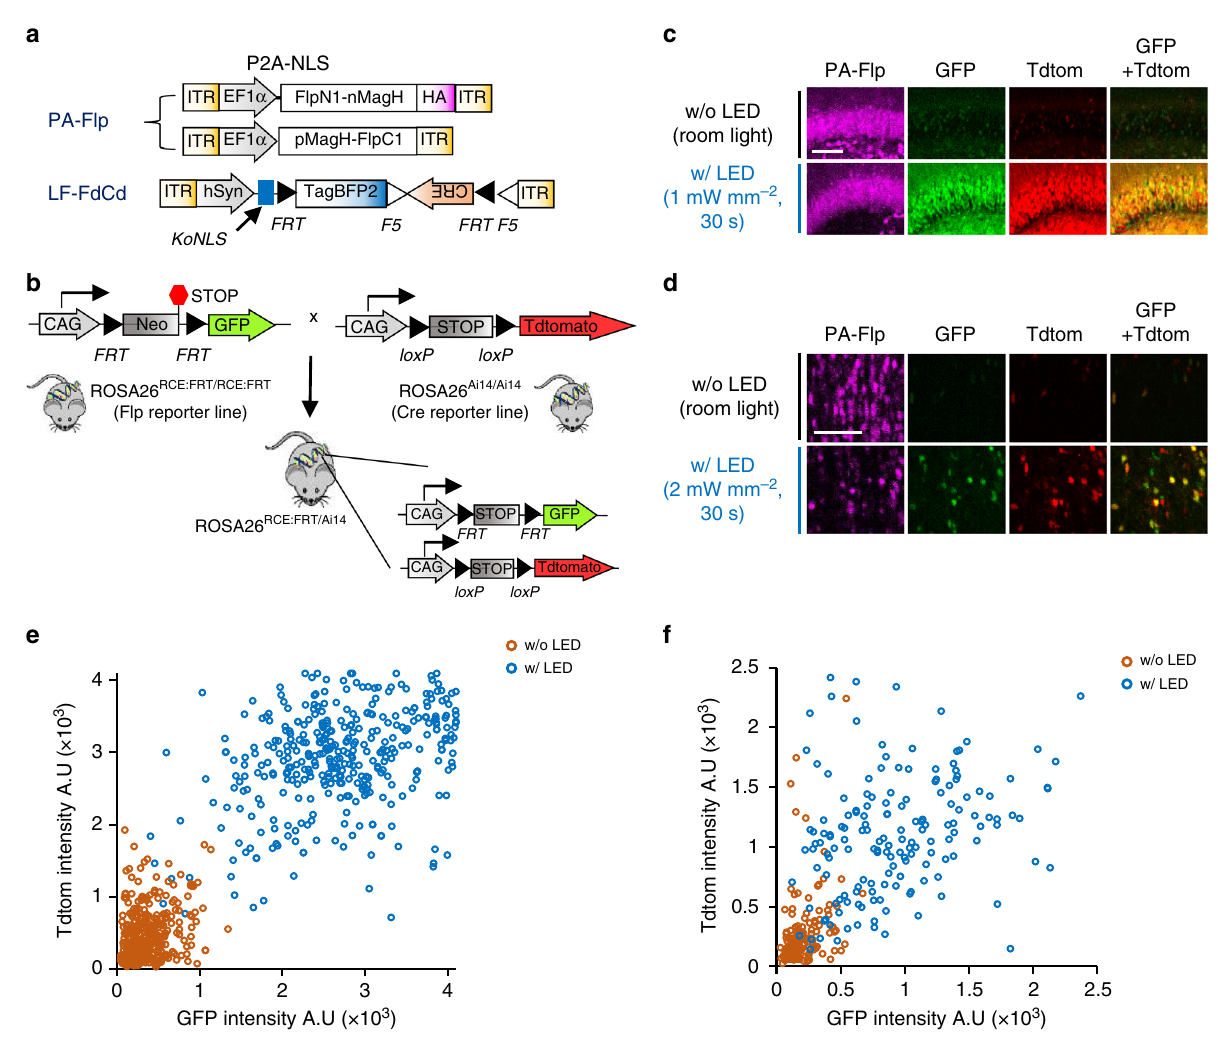
Fig. 3 Veri fi cation of PA-Flp-dependent Cre (PA-FdCre) system in ROSA26 RCE:FRT/Ai14 mouse line. a Schematic depicting AAVs carrying PA-Flp and Leak Free Flp-dependent Cre driver (LF-FdCd) as PA-Flp dependent Cre (PA-FdCre) systems. b Schematic depicting the generation of ROSA26 RCE:FRT/Ai14 mice. Flp reporter (GFP) and Cre reporter (TdTomato) alleles are located on the ROSA26 cassette in ROSA26 RCE:FRT/Ai14 mice. c , d Light-induced dual Flp and Cre activation in the hippocampal DG ( c ) or MS ( d ) of ROSA26 RCE:FRT/Ai14 mice (8 – 12-wk-old). Scale bar: 100 μ m. e , f Correlation between GFP and TdTomato fl uorescence intensity in the hippocampal DG ( e ) or MS ( f ) among PA-Flp – positive cells (magenta) in with (w/) LED and without (w/o) LED groups. A total of 200 – 500 cells were counted from each w/ LED and w/o LED group ( n = 4